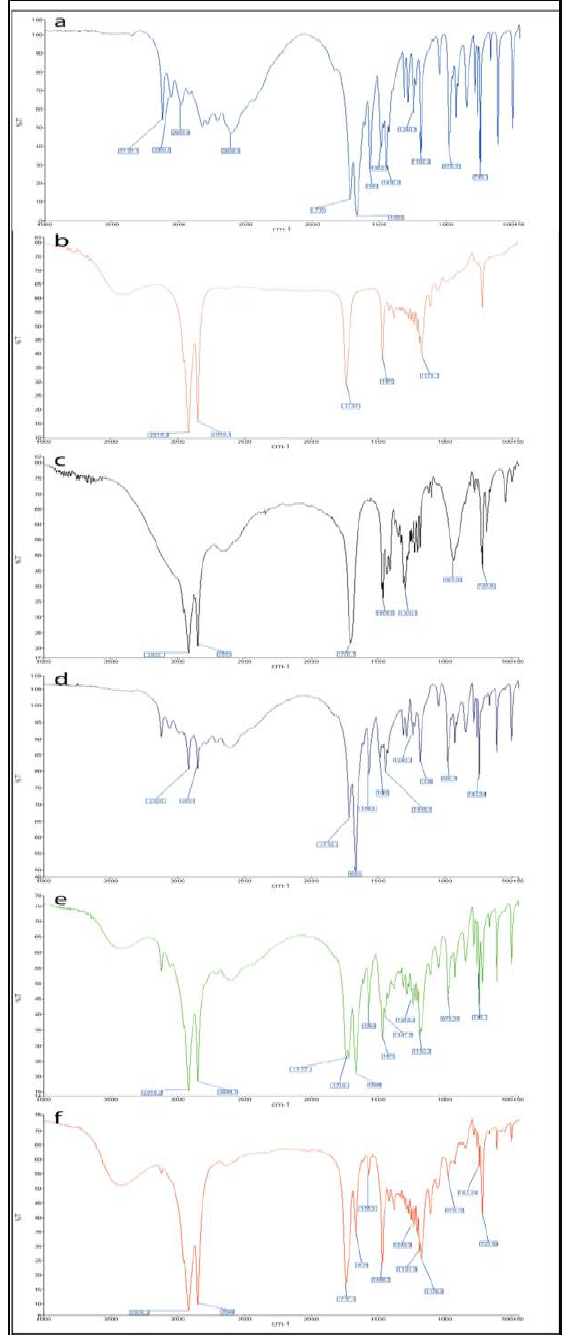
Figure 12: Fourier transform infrared images of TP (a), GB (b), SA (c), TP – NPs (d), TP – GB physical mixture (e) and F O (f)